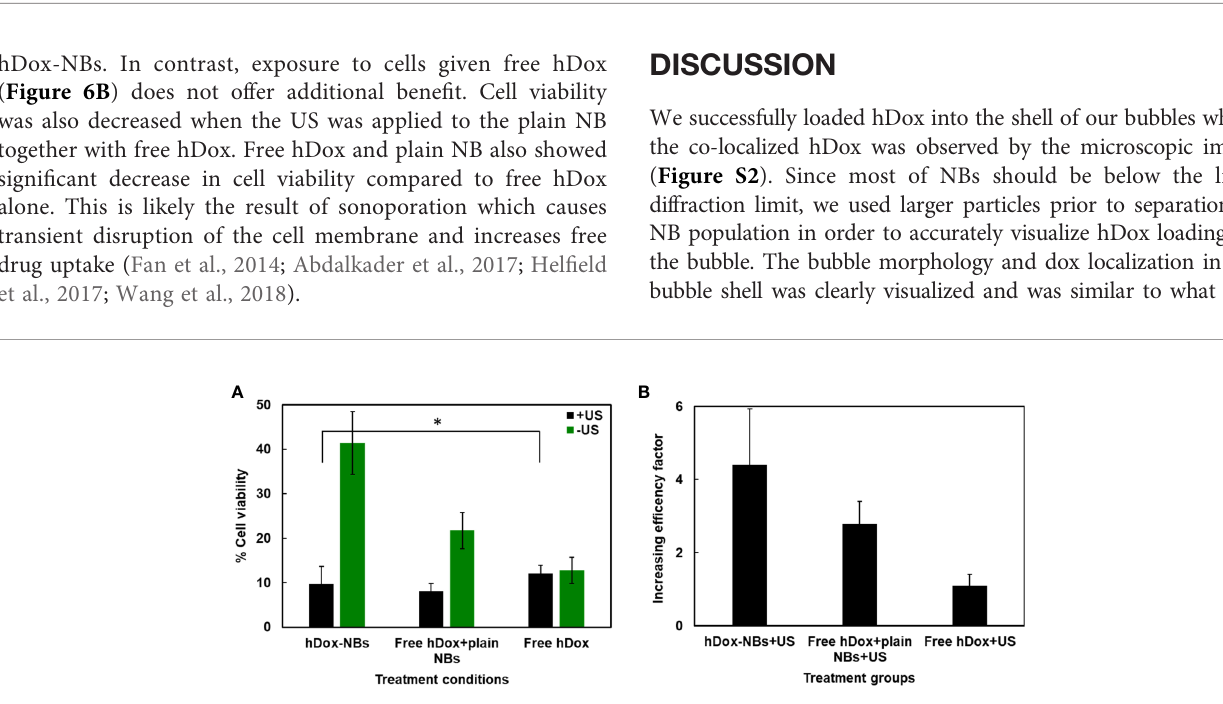
FIGURE 5 | Acoustic properties of hDox-NBs compared to unloaded nanobubbles (NBs) and NBs formulated with Dox.HCl (n=3 for each group). (A) Ultrasound signal decay of the three formulations over an 8-min exposure period. While both hDox and Dox.HCl increase the initial backscatter at t=0 compared to plain NBs, the signal decay is more rapid for Dox.HCl-NBs (B) Relative ultrasound signal decay rate illustrates the faster decay of Dox.HCl-NBs; Differences in initial ultrasound signal intensity (C) and remaining ultrasound signal at 8 min (% of signal at t=0) (D) . Error bars represent standard deviation. Asterisk indicates signi fi cant difference at p < 0.05.